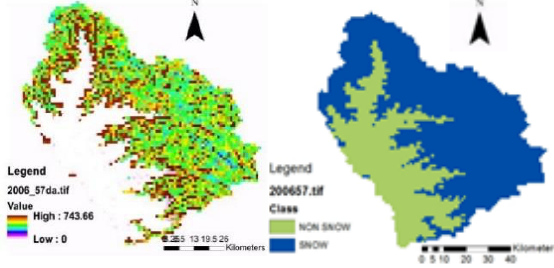
Figure 4.12. SWE (26 th Feb) Snow Cover (26 th